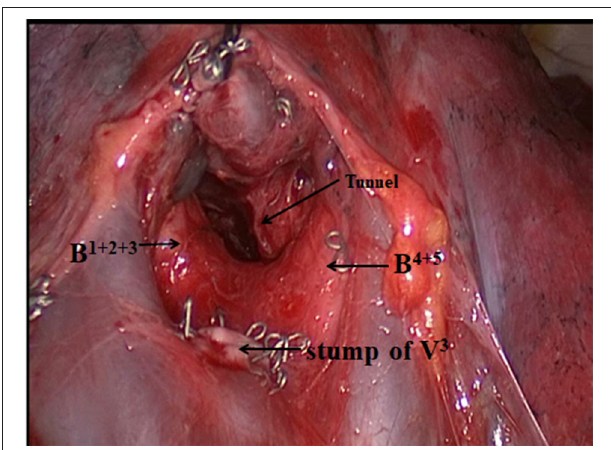
FIGURE 2 | Surgical view immediately before intersegmental tunneling. Arrows represent the tunneling point.